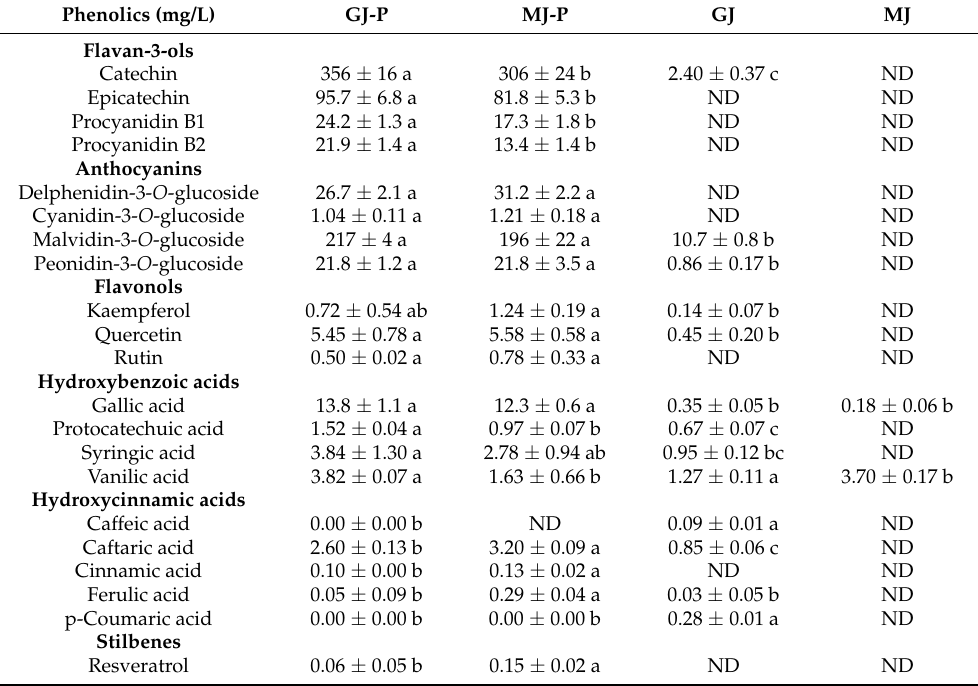
Table 2. Monomeric phenolic composition of the